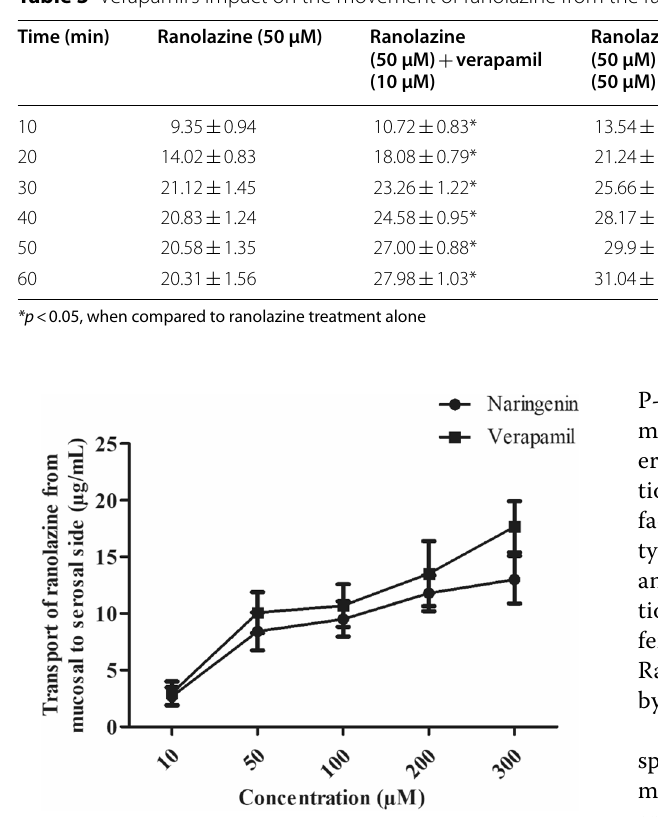
6). SDS single-dose study, MDS =